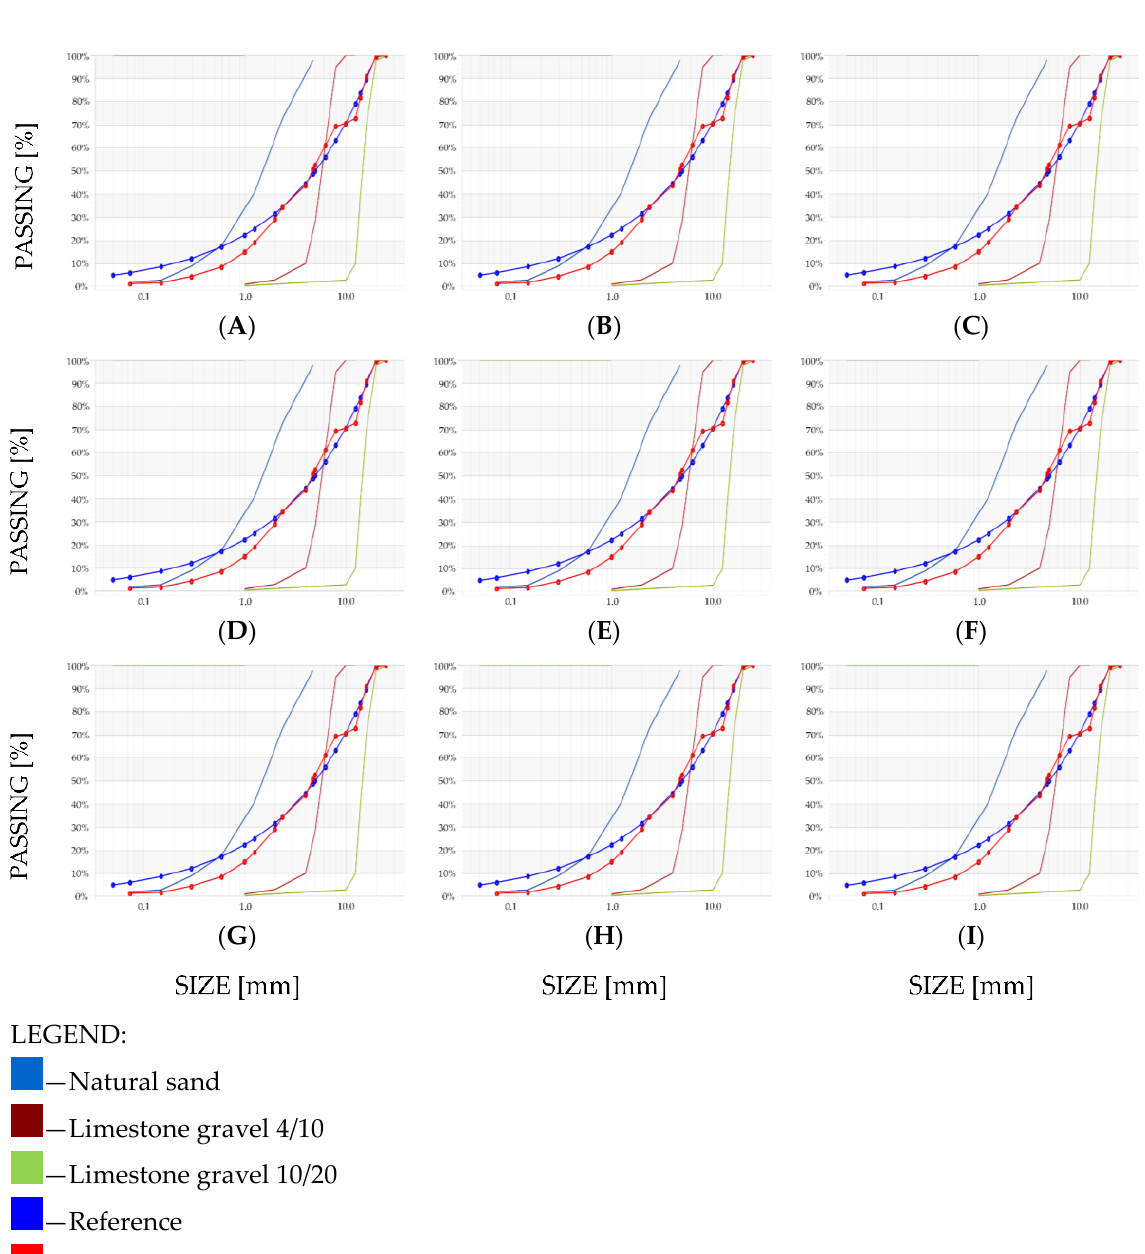
Figure A5. Gradings and fitting curves for Recipe #3—standard mix with superplasticizer (polycarboxylate ether), retarder (phosphate) and air entrainer (tensides) designed according to the Bolomey Method: ( A ) 10 MPa; ( B ) 15 MPa; ( C ) 20 MPa;